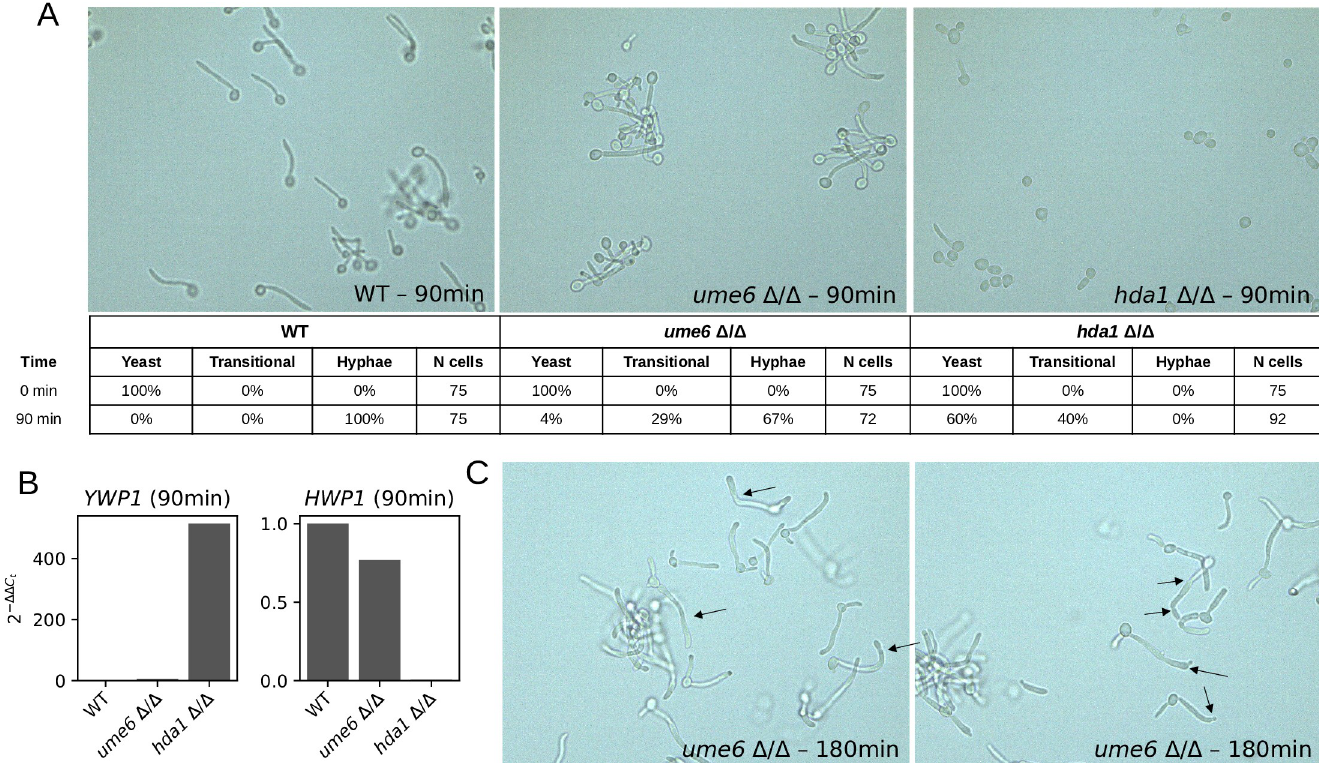
Fig 6. Experimental validation of model predictions. (A) Representative images and quantification of the experimentally observed growth phenotypes of the wildtype strain (left), ume6 Δ / Δ strain (middle), and hda1 Δ / Δ strain (right) C . albicans strains grown in RPMI medium at 37˚C, pH 7.0. (B) Quantitative real-time PCR (qPCR) quantification of YWP1 (yeast-wall protein) and HWP1 (hyphal-wall protein) transcript levels in the WT, ume6 Δ / Δ , and hda1 Δ / Δ strains at 90 mins. Normalized relative gene expression is quantified with respect to WT using 2 ð(cid:0) DD C t Þ . (C) Some ume6 Δ / Δ cells show constriction at sites of separation at 180 minutes, which is consistent with a pseudohyphal phenotype.